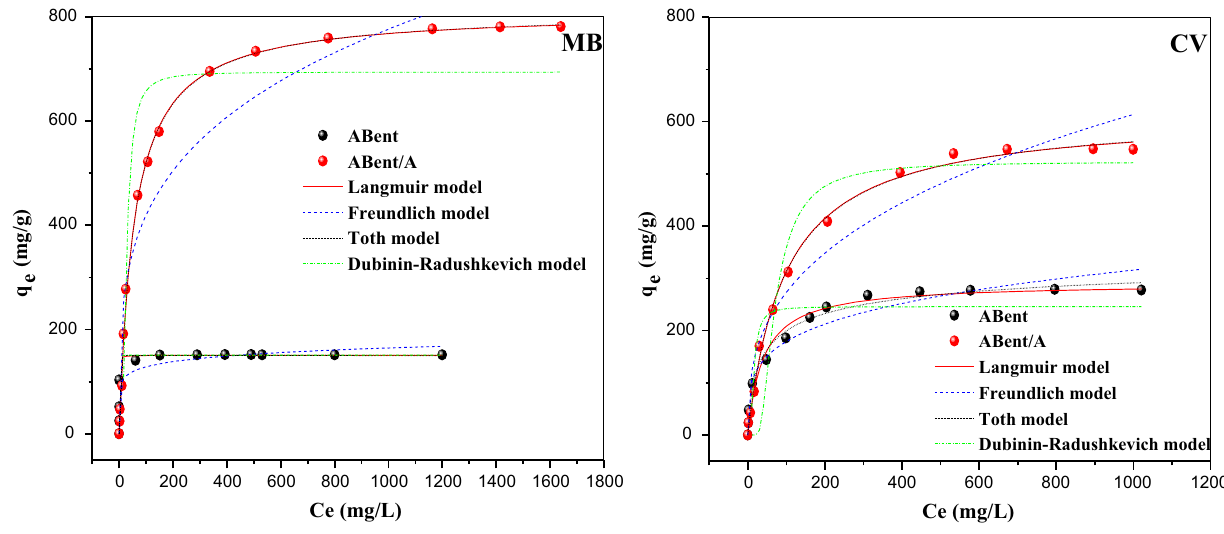
Fig. 5 Isotherms of MB and CV adsorption onto ABent and ABent/A ( C T = 25